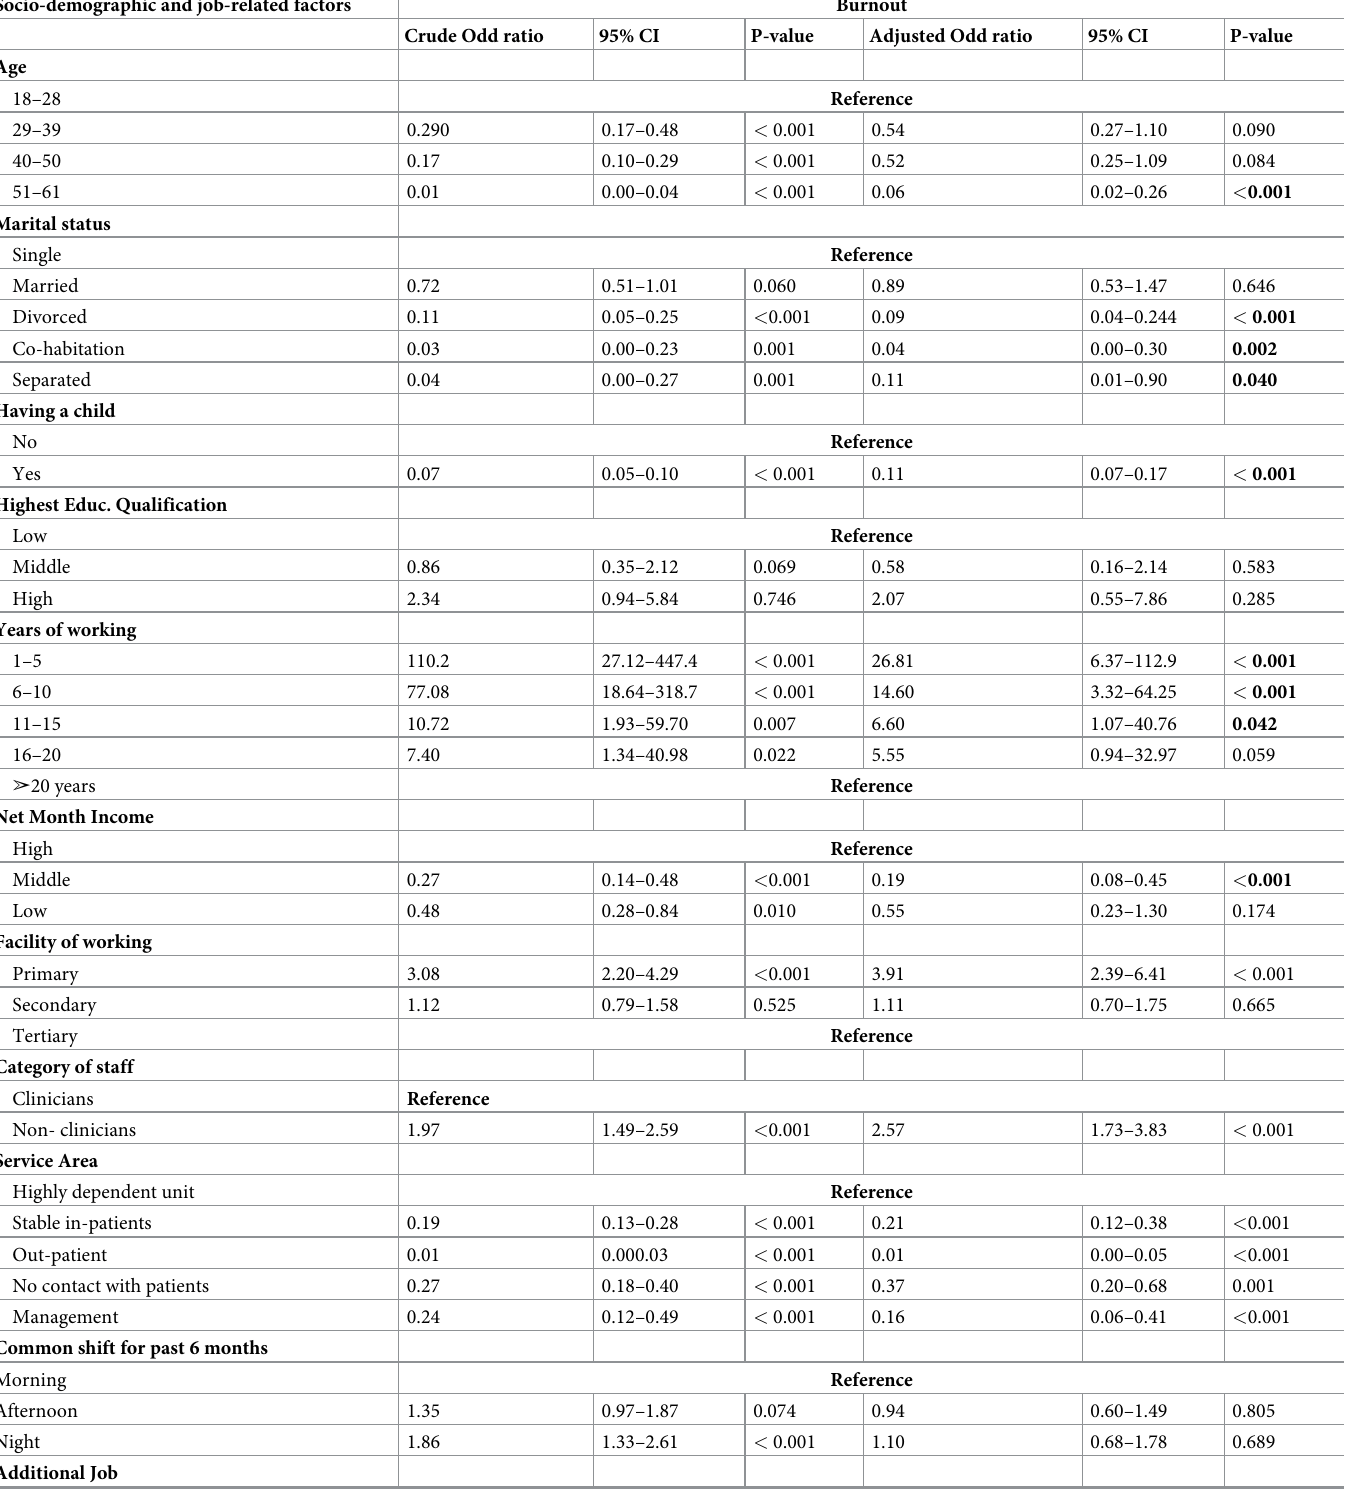
Table 5. Multivariate logistic regression between burnout and socio-demographic and job-related factors. Socio-demographic and job-related